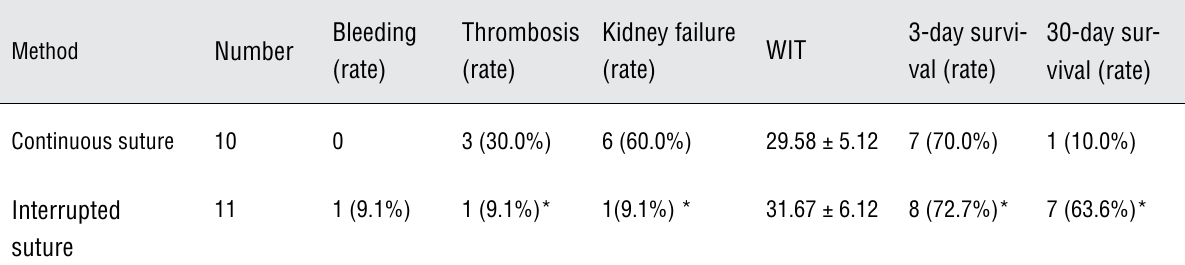
Table 2 - Surgical results of different method of artery anastomosis.